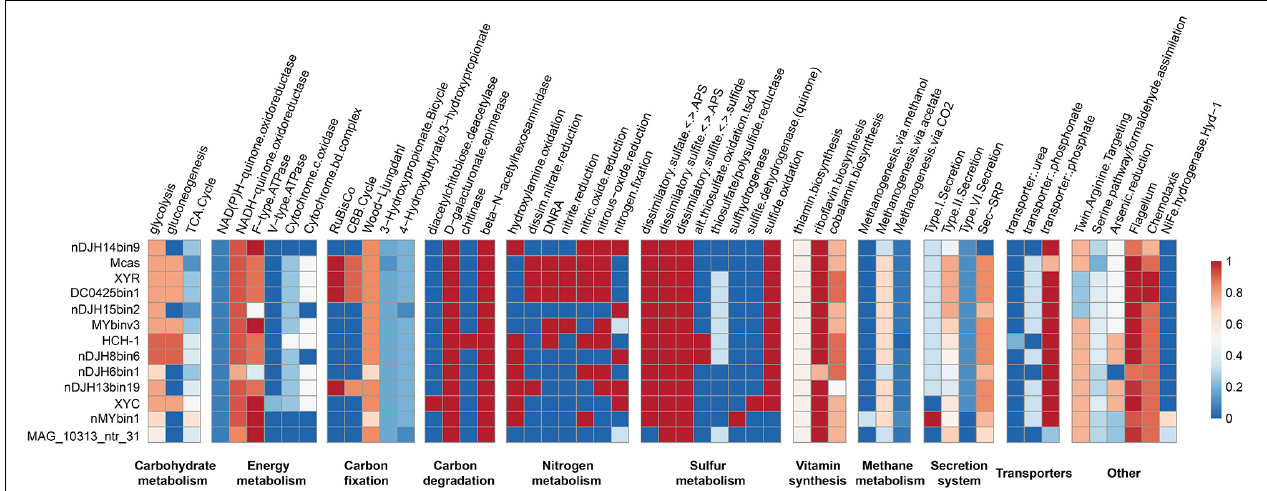
FIGURE 3 | Completeness of metabolic pathways of representative Nitrospirae MTB genomes. The scale number represents the completeness of major metabolic pathways inferred from the presence or absence of genes as determined by the KEGG-Decoder. Dark red represents a complete or highly complete pathway, and dark blue represents a pathway that is absent or highly incomplete. nDJH14bin9, Nitrospirae bacterium nDJH14bin9; Mcas, Ca . Magnetobacterium casensis; HCH-1, Ca . Magnetominusculus xianensis strain HCH-1; XYR, Ca. Magnetobacterium cryptolimnobacter strain XYR; XYC, Ca. Magnetomicrobium cryptolimnococcus strain XYC; DC0425bin1, Nitrospirae bacterium DC0425bin1; nDJH15bin2, Nitrospirae bacterium nDJH15bin2; MYbinv3, Nitrospirae bacterium MYbinv3; nDJH8bin6, Nitrospirae bacterium nDJH8bin6; nDJH6bin1, Nitrospirae bacterium nDJH6bin1; nDJH13bin19, Nitrospirae bacterium nDJH13bin19; nMYbin1, Nitrospirae bacterium nMYbin1; and MAG_10313_ntr31, Nitrospirae bacterium